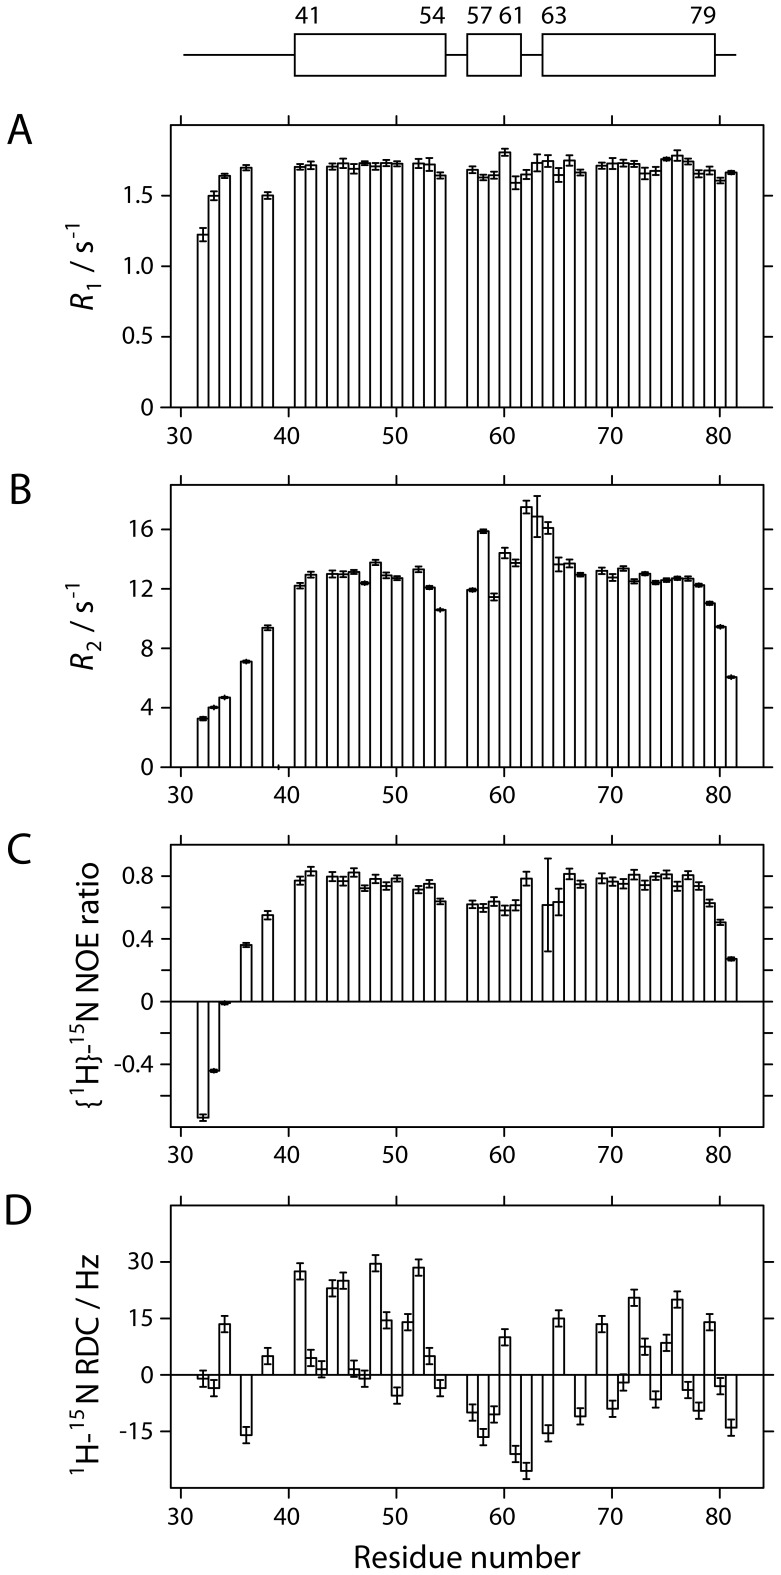

15N relaxation parameters.Underneath a schematic defining the boundaries of α-helices in the structure of pXqua QUA1-C59S, NMR parameters for backbone amide sites are plotted as a function of residue number for: (A) the 15N longitudinal relaxation rate, R
1; (B) the 15N transverse relaxation rate, R
2; (C) the {1H}-15N heteronuclear Overhauser effect ratio (I’/I
0, where I’ is the intensity when the 1H spectrum has been saturated and I
0 is the intensity in the reference spectrum); and (D) 1H-15N residual dipolar coupling measurements.